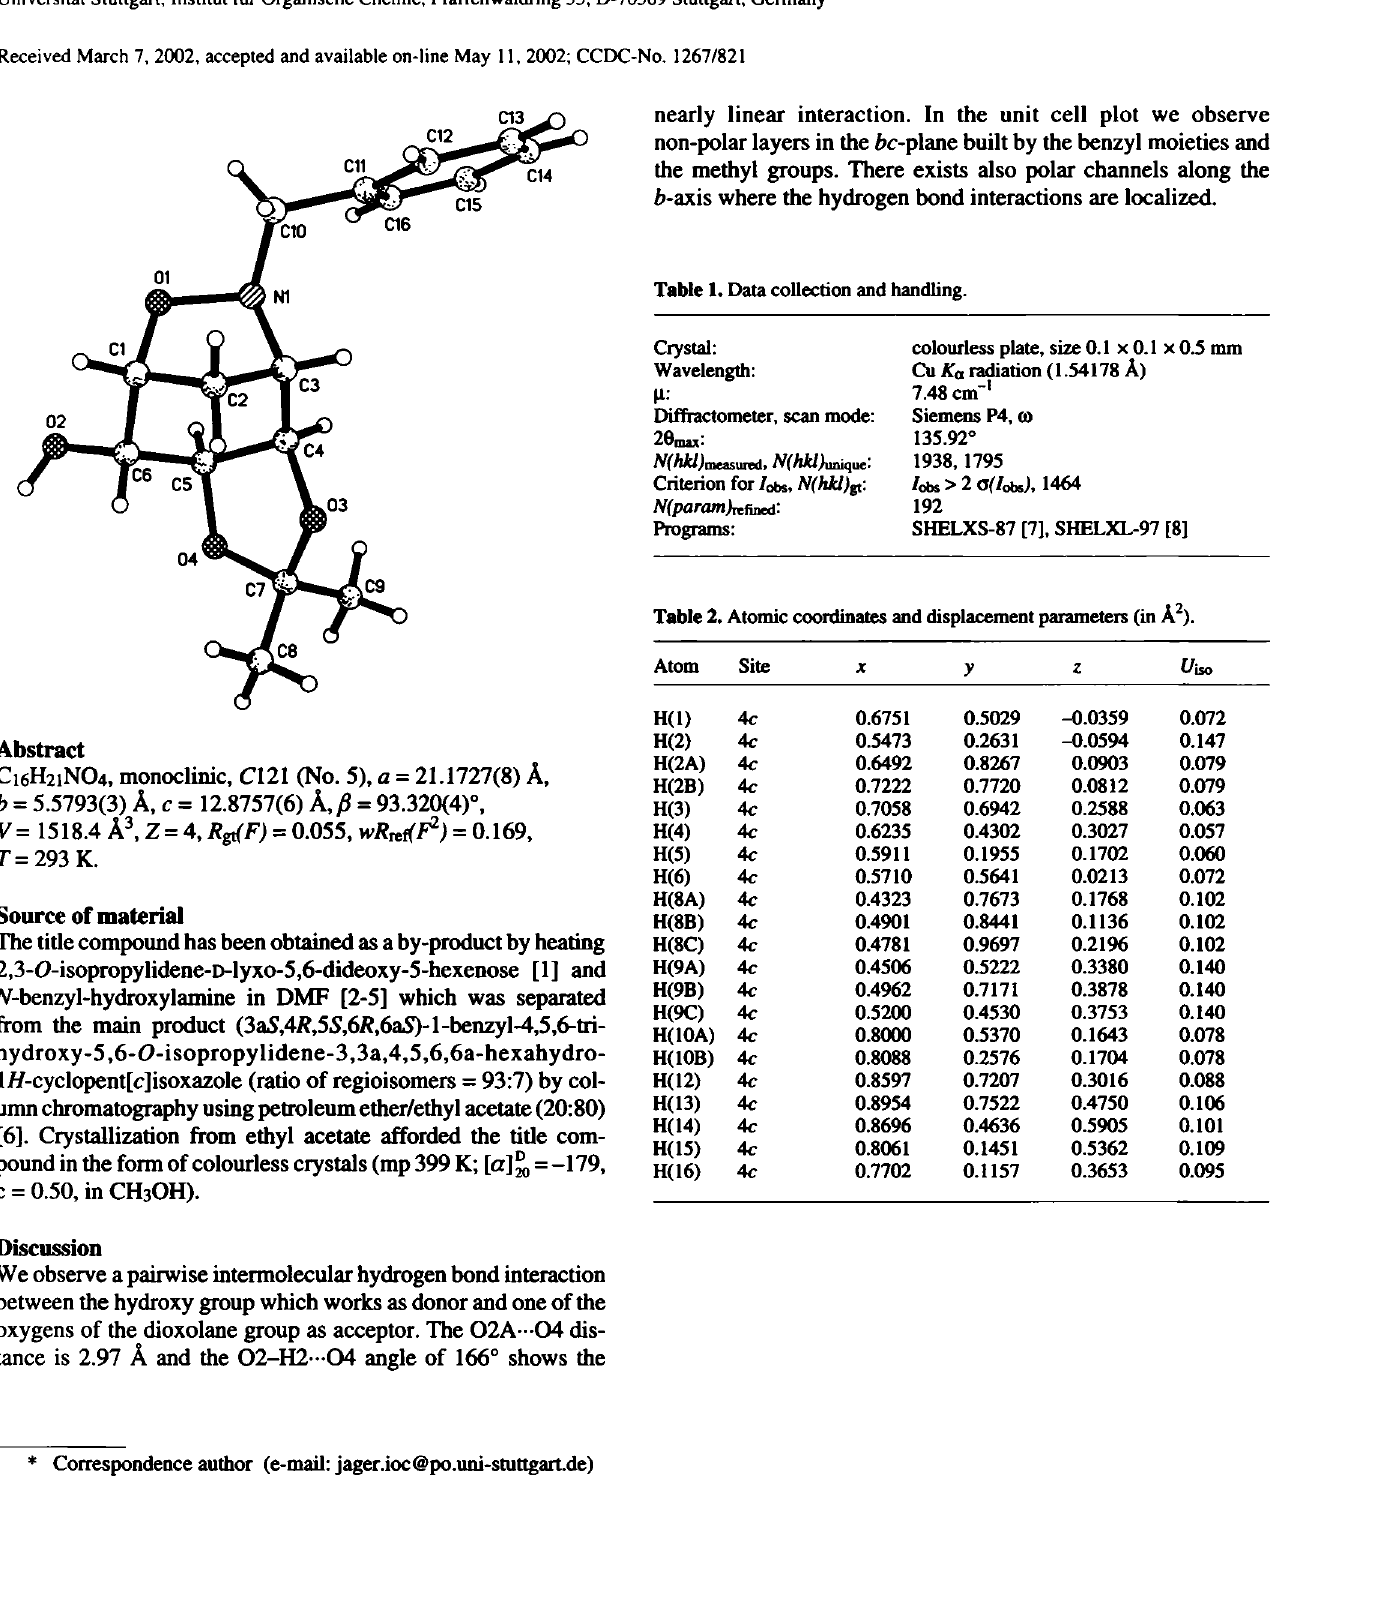
Table 1. Data collection and handling.